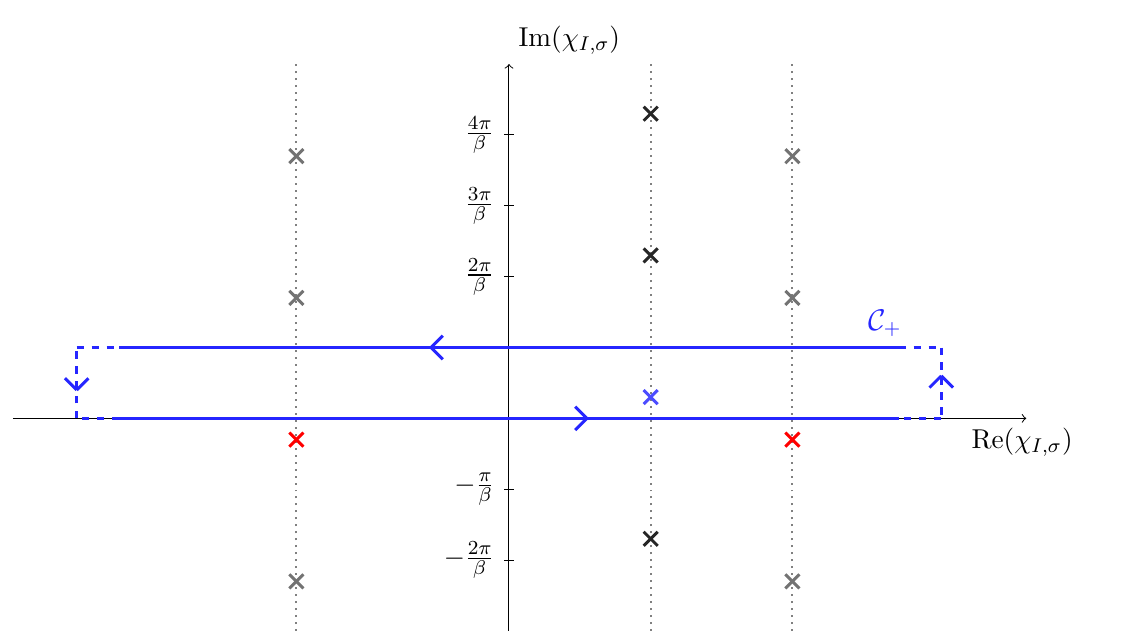
Figure 5 . The contour C + for the case of the [1 ; 2] surface operator in SU(3) at 1-instanton.